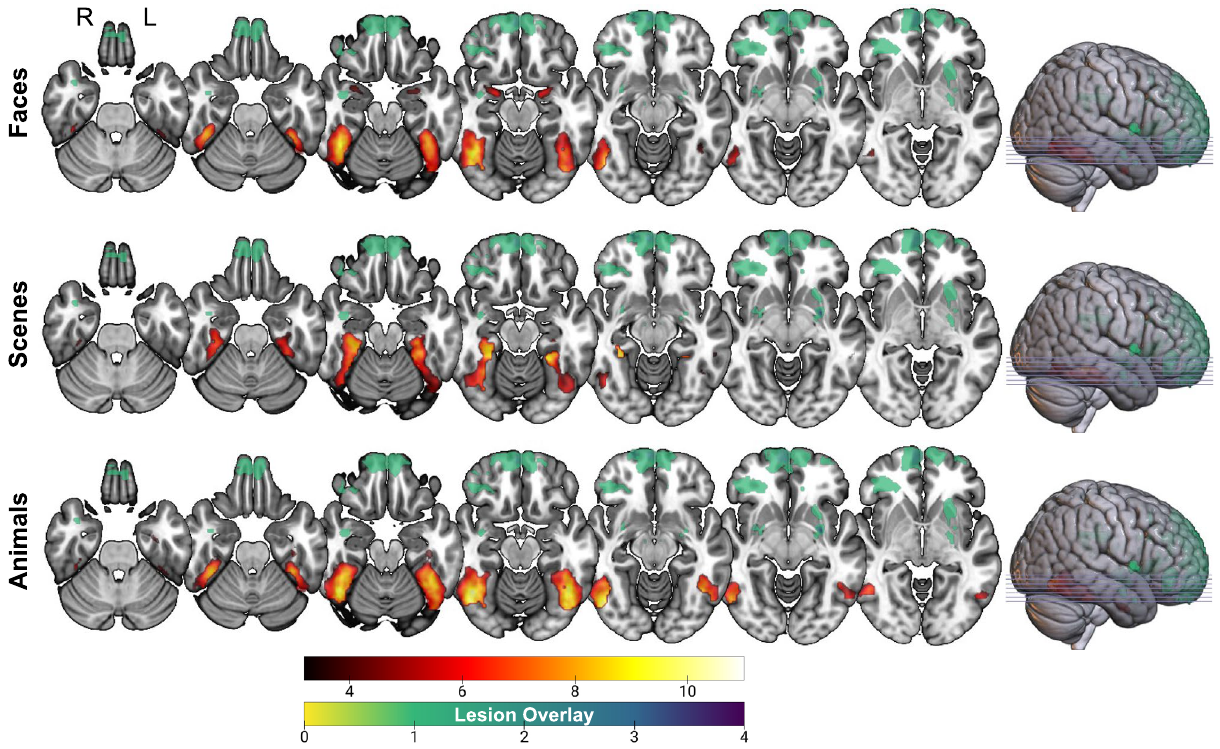
Figure 4. Overall functional activity elicited during the episodic encoding task for the whole sample. Significant clusters during encoding of faces, scenes, and animals are shown in red/yellow. There was no overlap between these clusters and TBI lesions (green).